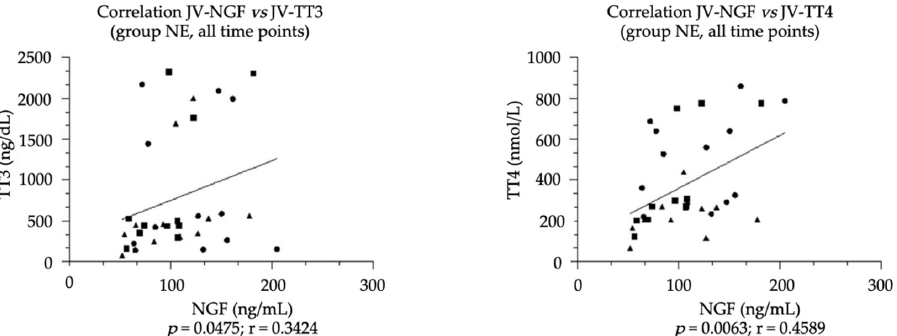
Figure 3. Correlation found in NE group between NGF plasma levels and TT3-TT4 serum levels in samples obtained from foal’s jugular vein at three consecutive time points (T0: birth; T24: h from birth; T72: h from birth). The correlation between NGF and TT3 levels was calculated using Spearman’s non-parametric correlation, whereas the correlation between NGF and TT4 levels was calculated using Pearson’s parametric correlation.